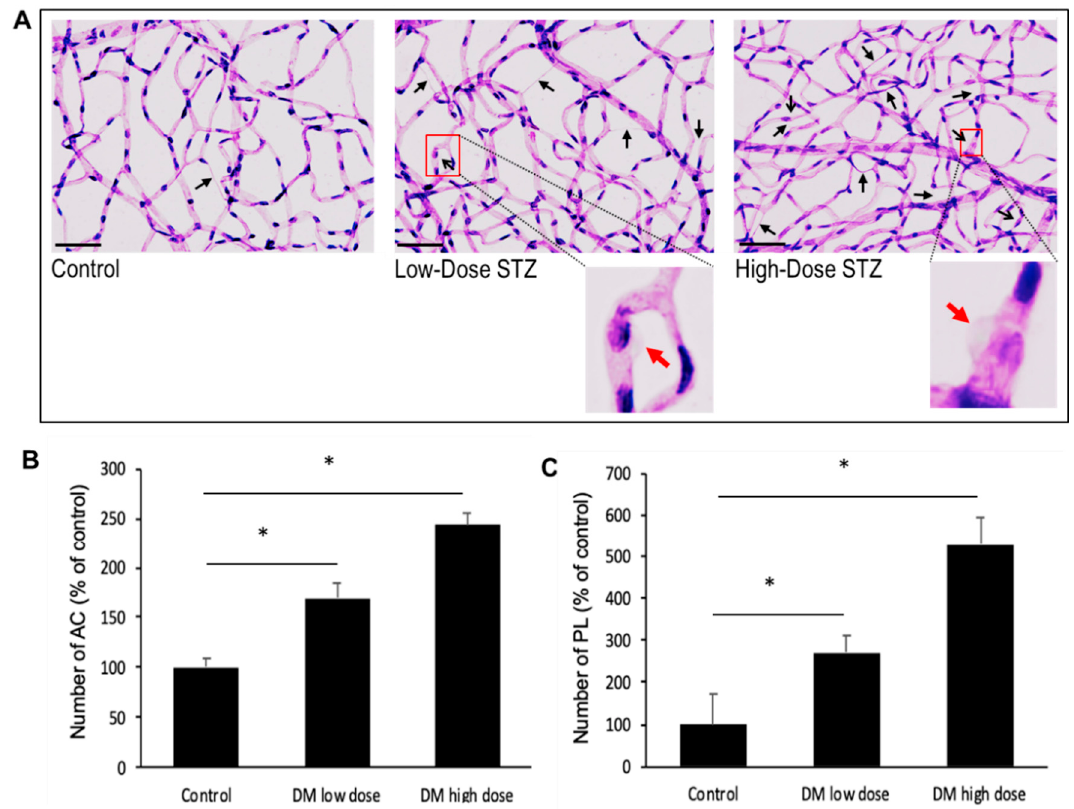
Figure 6. Effects of moderate or severe diabetes on the development of retinal vascular lesions. ( A ) Representative RTD images show increased number of AC (black closed arrows) and PL (black open arrows) in the retinas of moderately diabetic and severely diabetic mice compared to those of control mice ( n = 6). Scale bar = 100 µ m. Enlarged views of pericyte ghosts (red arrows) are shown in boxed areas. ( B ) Graphical illustration of cumulative data shows the number of AC and ( C ) PL progressively increases with diabetes severity. Data are expressed as mean ± standard deviation * = p < 0.05.